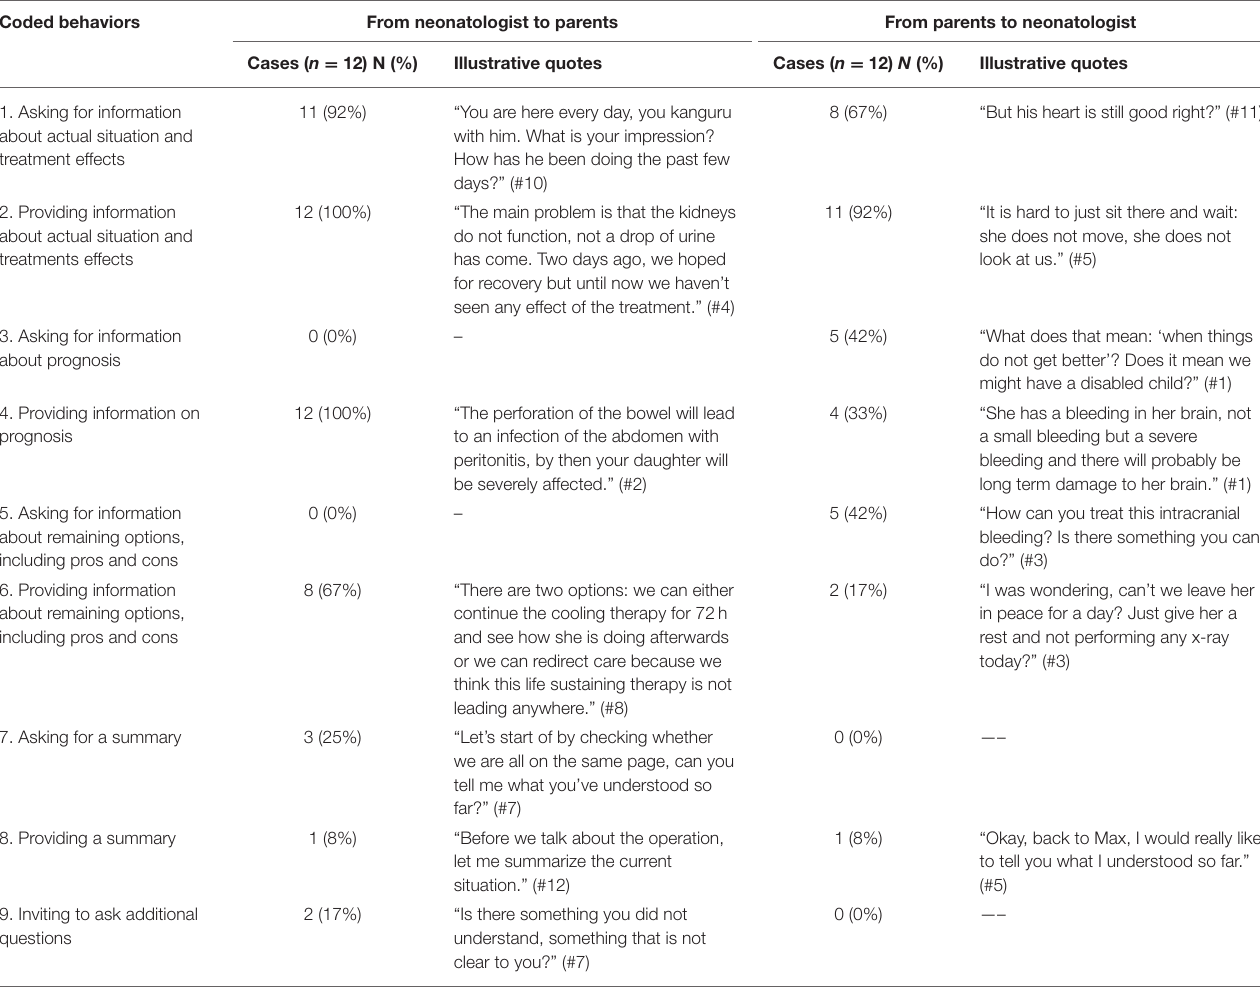
TABLE 3 | Stage 1: exchange of information. Coded